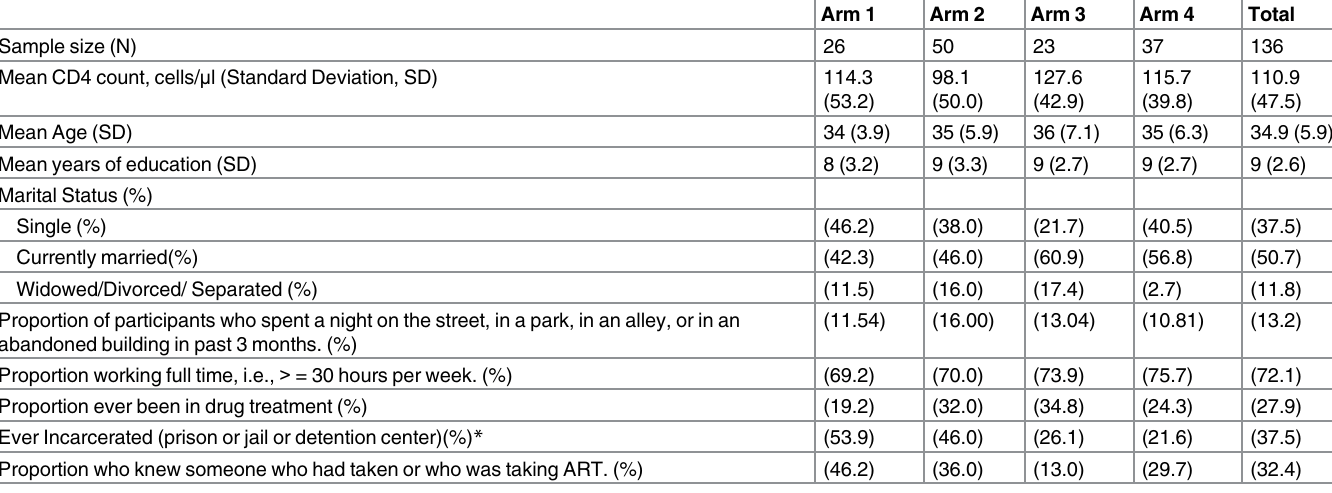
Table 1. Baseline characteristics of participants by trial arm (n =